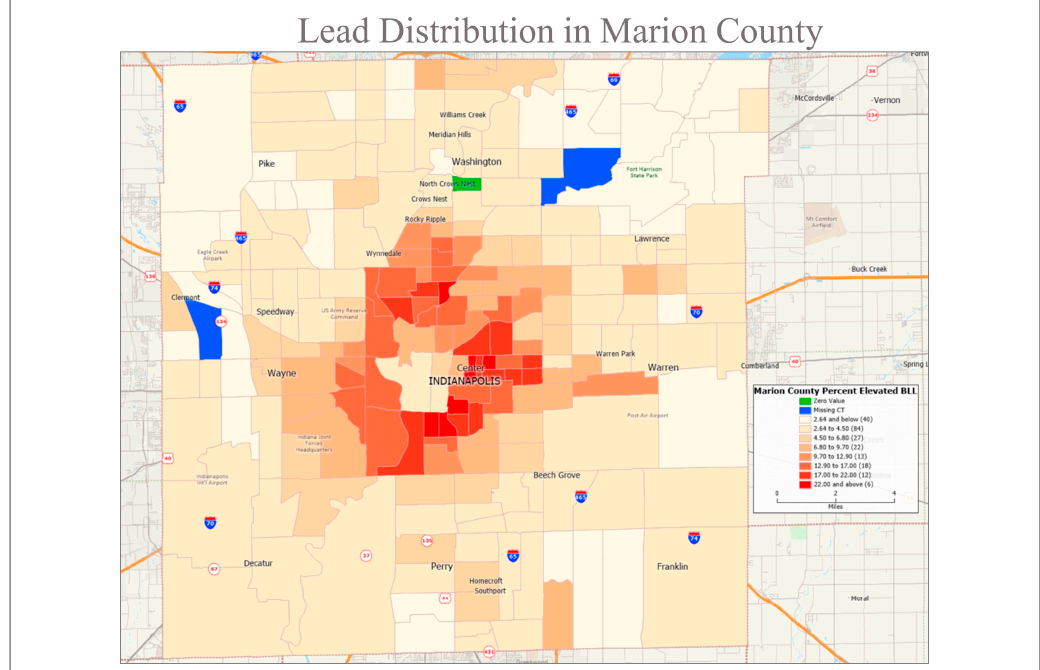
Figure 1. Map of blood lead levels (BLL) for children tested in Indianapolis from 2005–2015 aggregated at the census tract level (data from Reuter, 2018 [26]). These results reveal areas in the city with persistent Pb exposure to children, which is likely driven largely by soil and dust sources of legacy Pb from a mixture of leaded gasoline, lead-based paints, and industrial sources (Laidlaw and Filippelli, 2008 [23]).